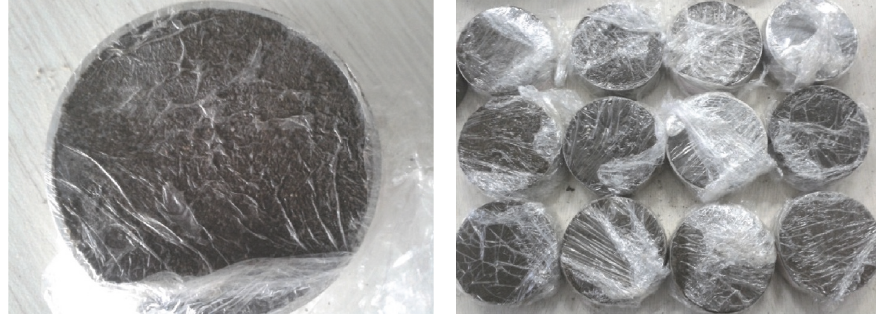
Figure 3: Standard specimens.